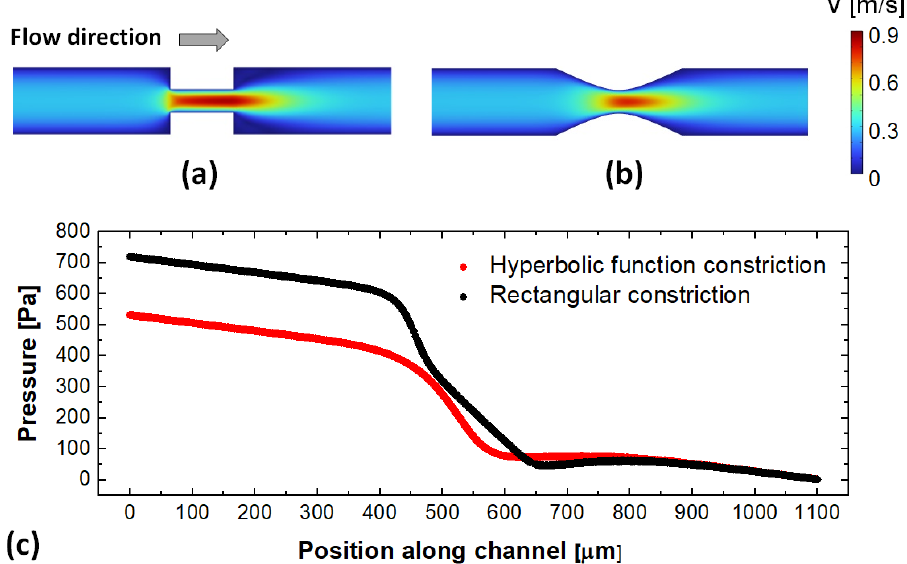
Figure 1. Velocity field maps along the center plane for: ( a ) a channel with a rectangular constriction and ( b ) a channel with a constriction defined by a hyperbolic function, respectively. ( c ) Corresponding pressure gradient profiles along the two channels, showing lower pressure drops for the same constriction diameter for the hyperbolic design.